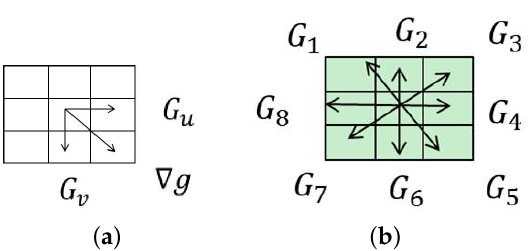
Figure 2. The original and our improved image gradient calculation methods. ( a ) Original gradient Calculation; ( b ) Improved gradient Calculation.